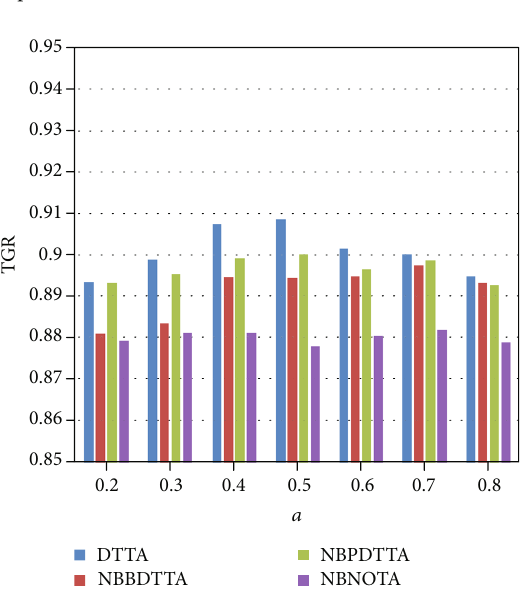
Figure 10: Performance impact of λ .